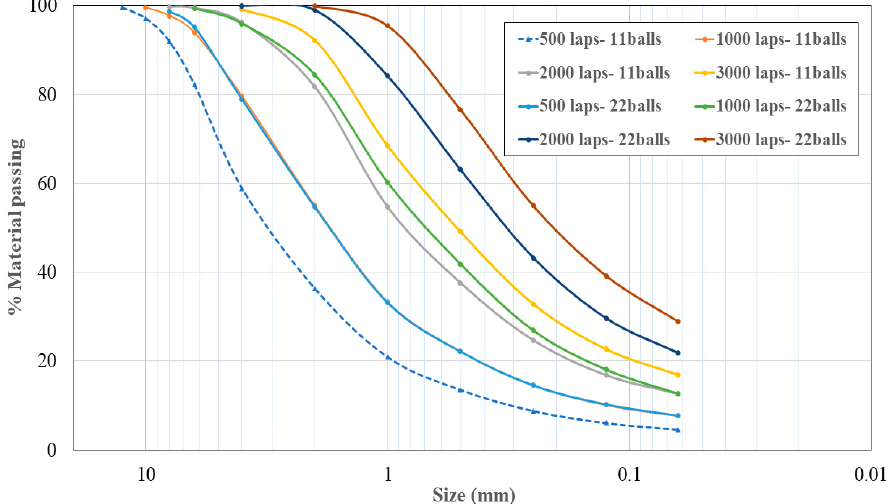
Figure 1. Particle size distribution of Acanthocardia tuberculata shells (ATS) with different grinding processes.